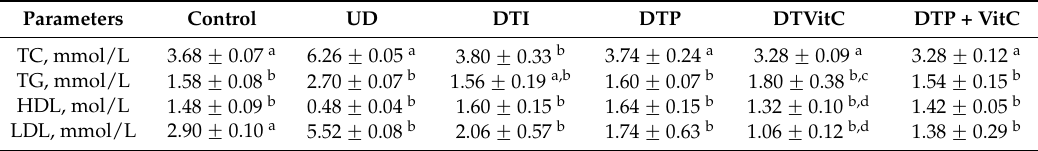
Table 4. Lipid profile of alloxan-induced diabetic rats treated with insulin, probiotic and vitamin C. Parameters Control UD